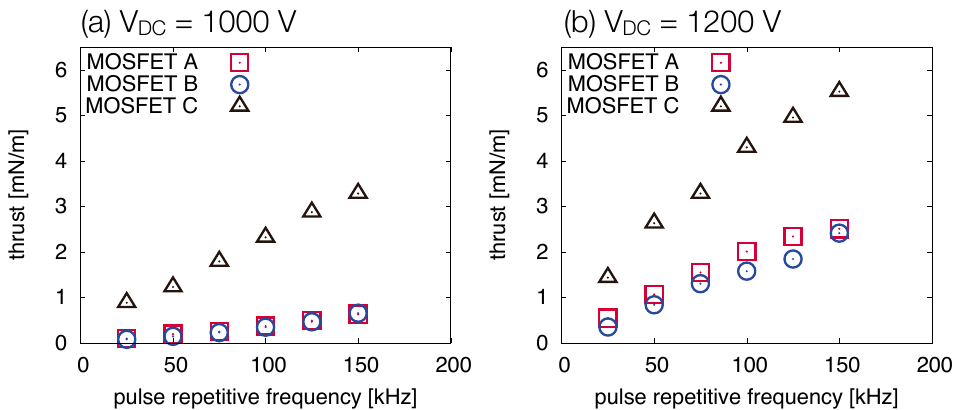
Figure 7. Time-averaged thrust generated by DBD plasma actuator as a function of repetitive pulse frequency for different MOSFETs for DC voltages of ( a ) 1000 V and ( b ) 1200